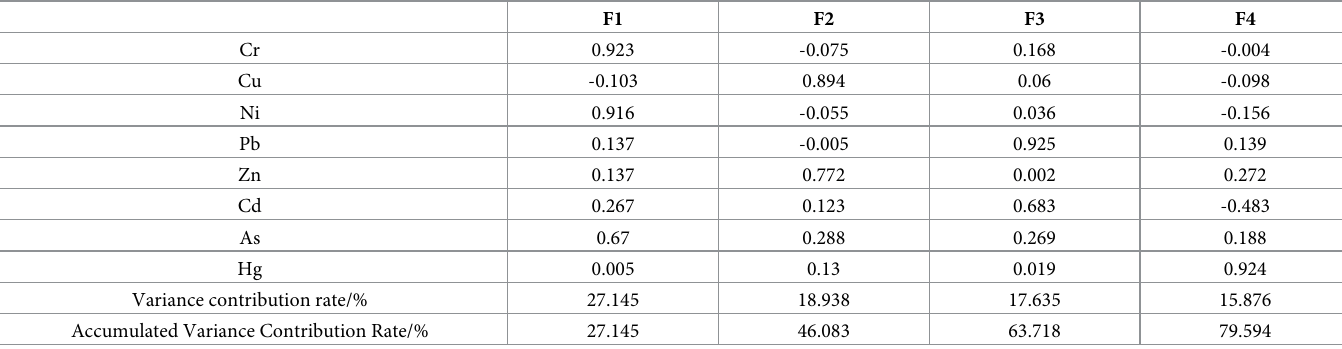
Table 2. Factors loadings of potentially toxic elements in